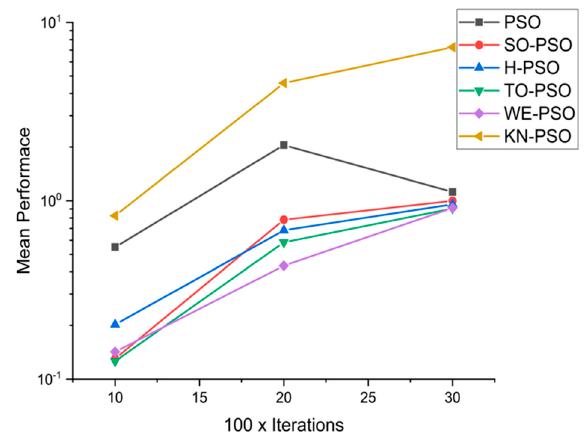
Figure 15. Convergence curve on fn9.